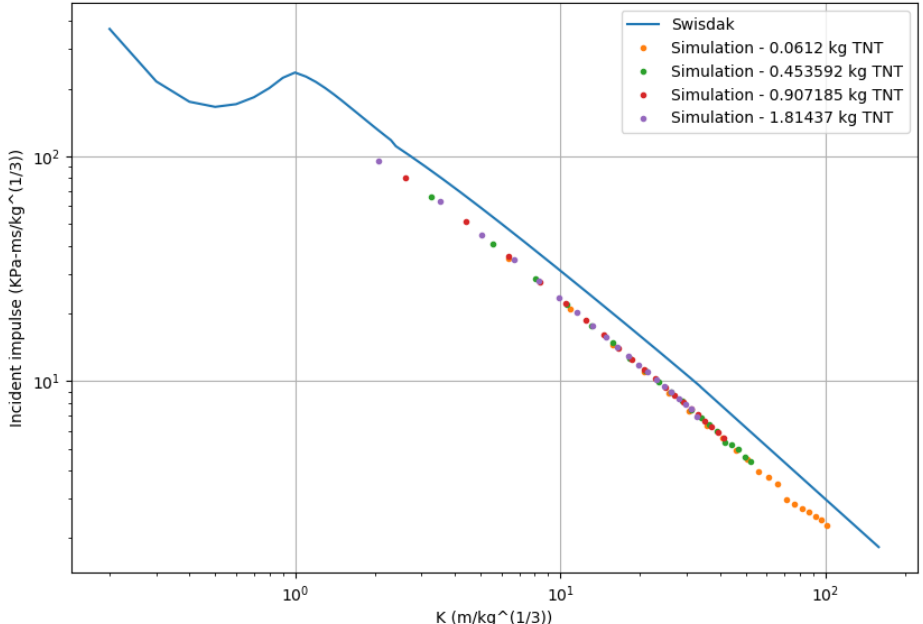
Figure 11. Positive impulse versus K factor from the four TNT hemispherical simulations in compari- son with the KB curve from